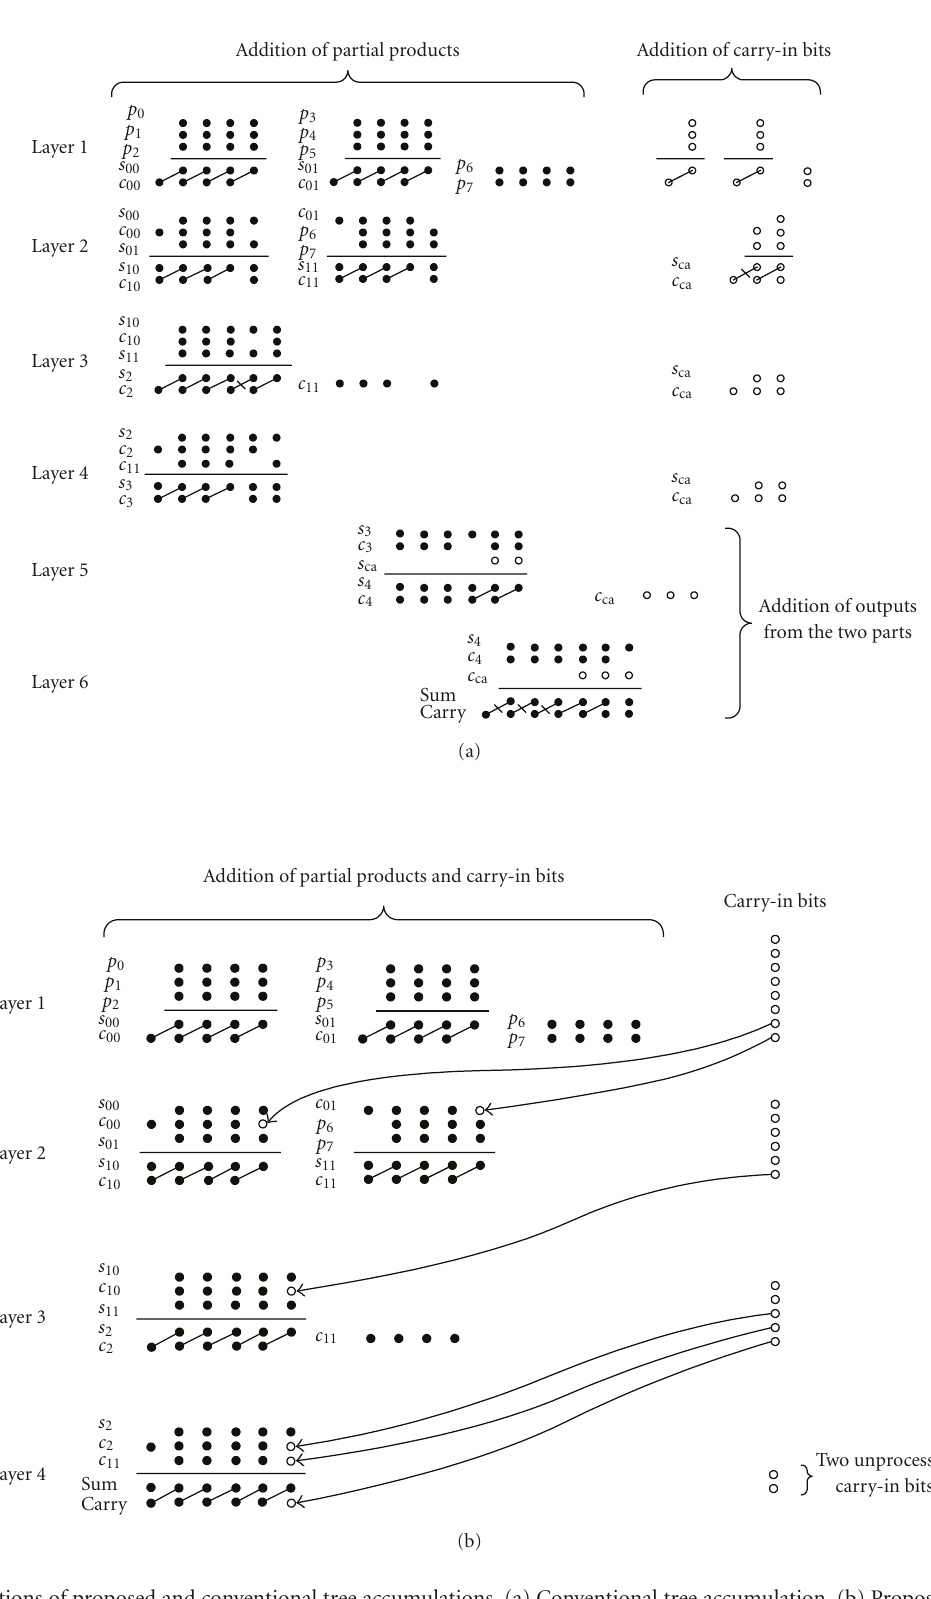
Figure 6: Operations of proposed and conventional tree accumulations. (a) Conventional tree accumulation. (b) Proposed tree accumula-